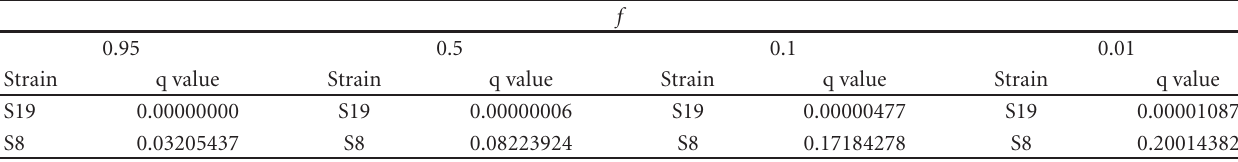
Table 2: Emerging strains detected in the pulmonary TB by using spoligotypes in